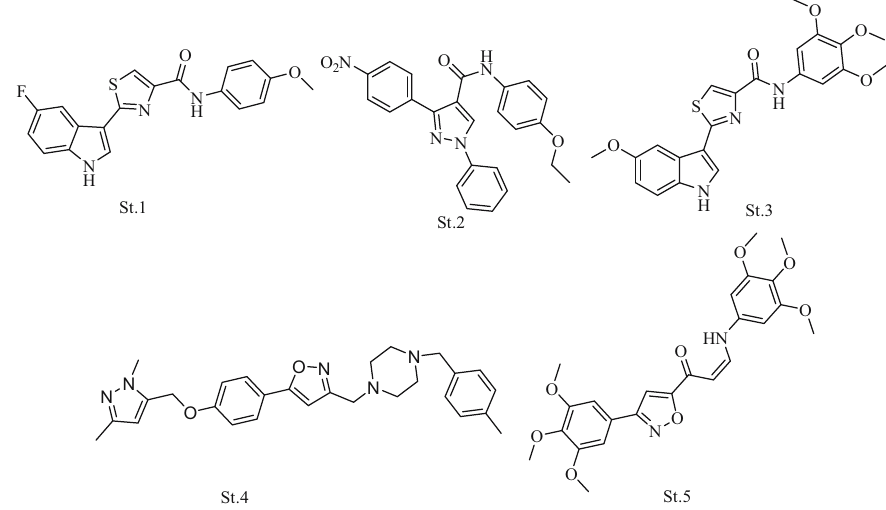
Figure 2: Compounds with fl uoro - aryl, heterocyclic - amide, methoxy phenyl, and isoxazole with anticancer